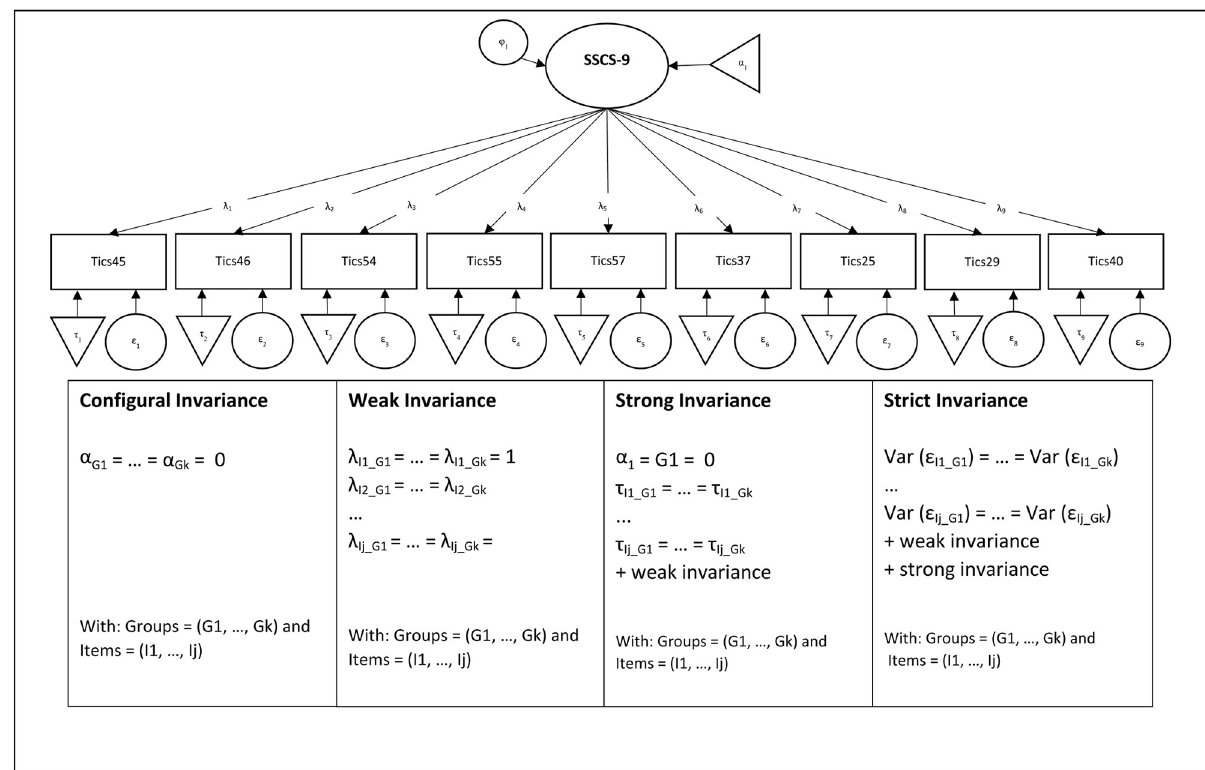
Fig 1. Models relevant for the invariance